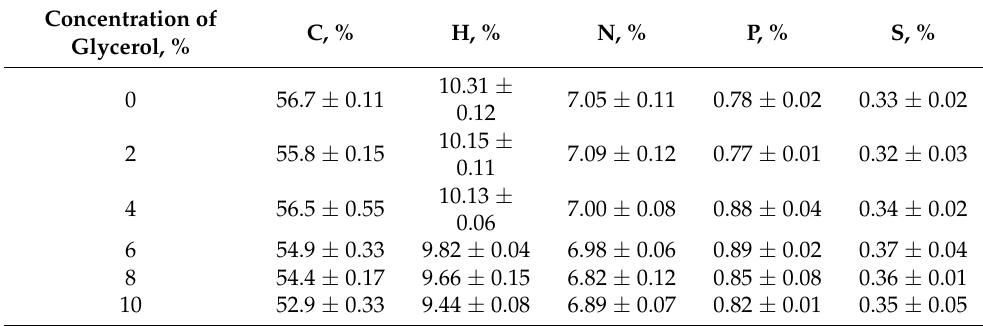
Table 3. Elemental composition of the microalgae Chlorella sp. biomass after cultivation in a nutrient medium with the addition of liquid waste after biogas production from distillers’ grain and glycerol. Concentration of C, % H, % N, % P, % S, Glycerol, %